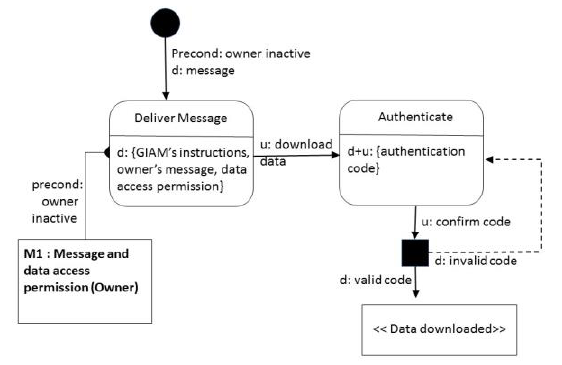
Fig. 7 - MoLICC diagram for trusted